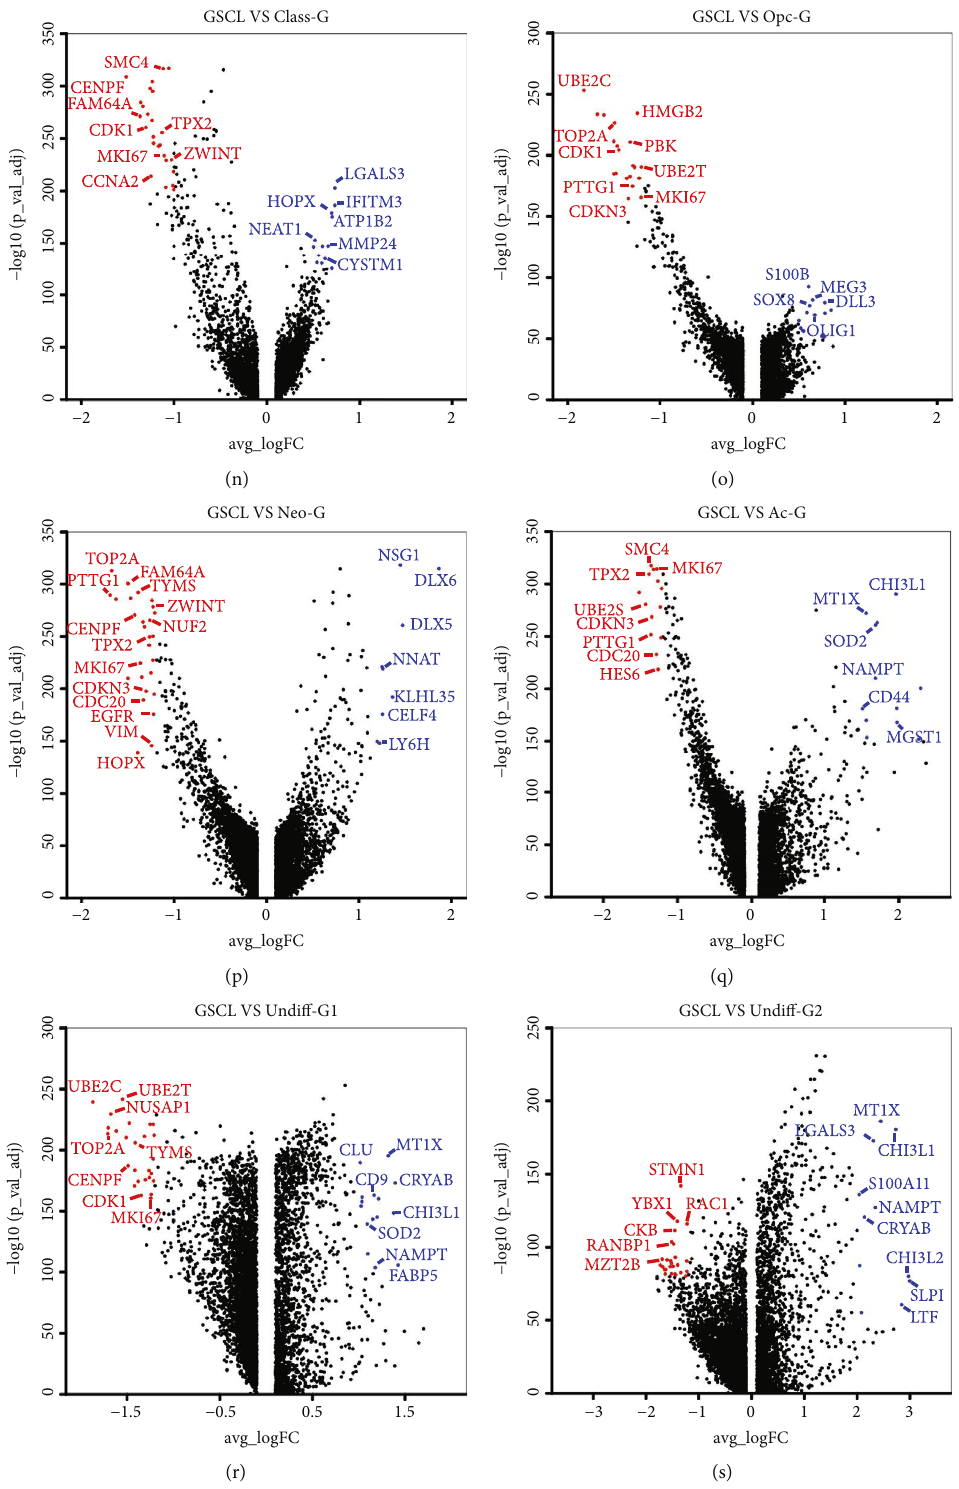
Figure 2: Di ff erences in cell composition and gene expression in GBM samples. (a) UMAP plots of tumor cells by Monocle3 method. (b) Pseudotime trajectory of tumor cells. (c) UMAP plot of tumor cells color-coded for each sample. (d) Tumor cell subset distributions across samples. (e) Di ff erences in cell proportion of GBM samples in each tumor cluster. (f) Dot-plot heatmap of the most signi fi cant genes of each cluster in tumor cells. (g – l) Violin plots showing di ff erent expressions of GSCL, Undi ff -G, Ac-G, Opc-G, Class-G, and Neo-G markers in each tumor cluster. (m) Violin plots showing previously reported markers expressed in GBM are distributed in GSCL and malignant cells. (n – s) Di ff erences in gene expressions between GSCL and malignant cells clusters. ∗ means p < 0 : 05